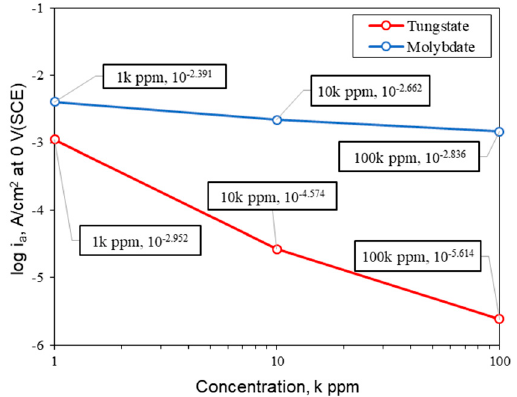
Figure 3. Effect of tungstate and molybdate ions on the anodic current density at 0 V(SCE) obtained from Figure 2.